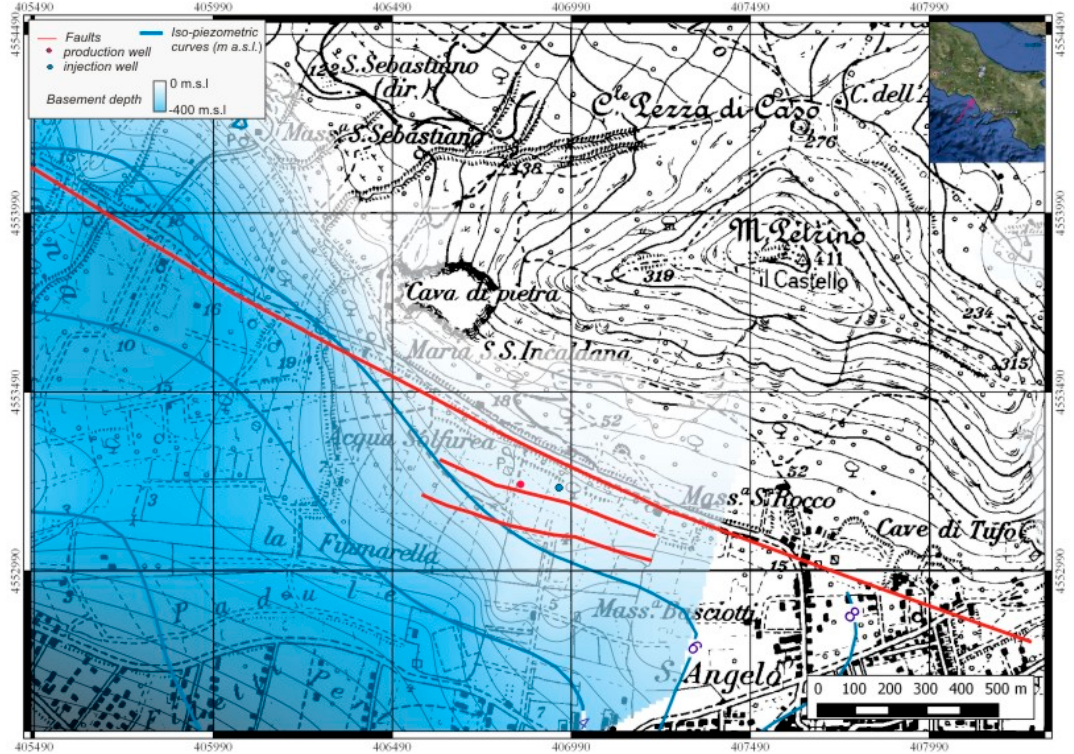
Figure 2. Localization and hydrogeological structural setting of the analyzed site. (Adapted from [1]). This is at SW of Mt. Massico, which is a carbonate monocline trending SW bounded by high-angle normal faults along the margins of the Garigliano (NW), Volturno (SE), and Mondragone (SW)